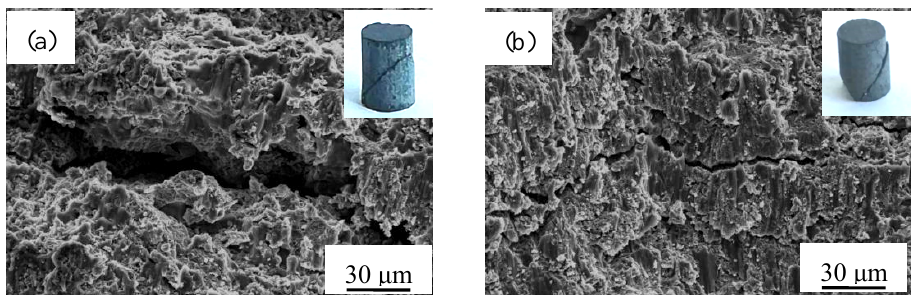
Figure 9. Macro photos and SEM micrographs of compression fracture surfaces of (B 4 C+Ti)/Mg ( a ) and (B 4 C+Ti)/AZ91D; ( b ) composites corresponding to Figure 8.